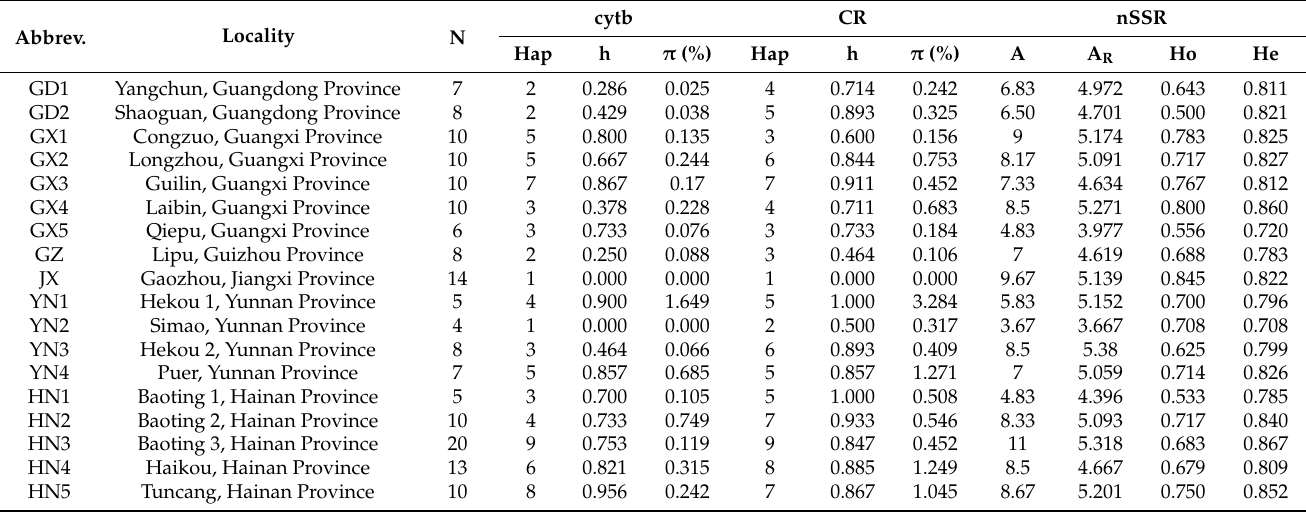
Table 1. Sampled populations with their abbreviations and the number (N) of Hipposideros larvatus samples used in this study and genetic diversity, including haplotype diversity (h) and nucleotide diversity ( π ) of the mitochondrial cytb and control region (CR) fragments, and mean number of alleles at each locus (A); allelic richness of each locus (A R ), observed (Ho) and expected heterozygosity (He) of six microsatellite loci.